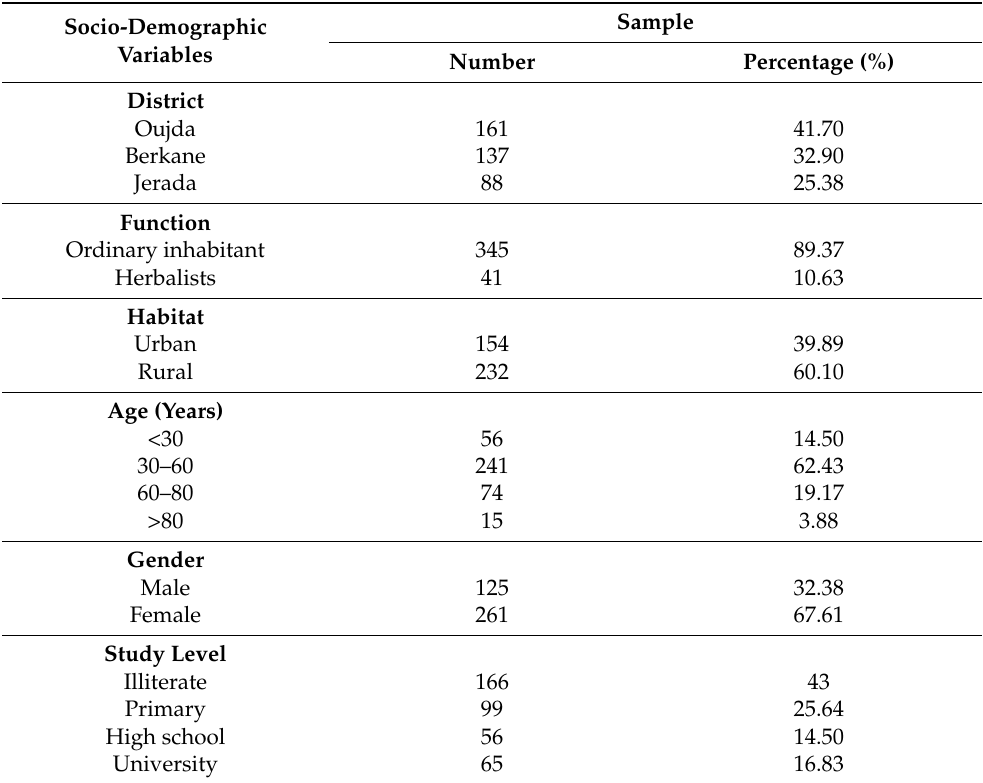
Table 1. Informant socio-demographic